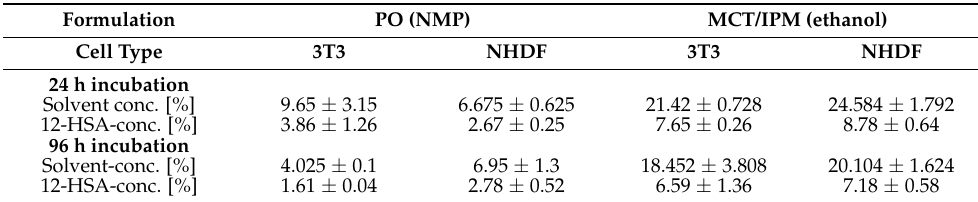
Table 4. The half-maximal inhibitory concentration ( IC 50 ) values of the solvents themselves and expressed as the corresponding 12-HSA concentrations [%], calculated as arithmetic means ± SDs of each triplicate